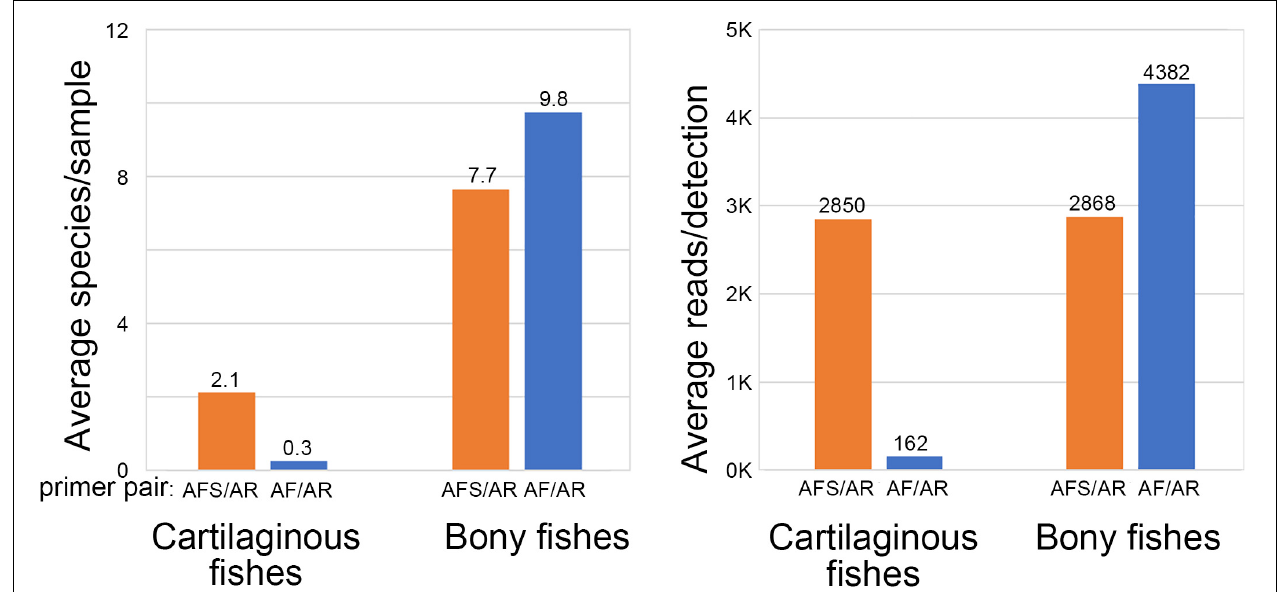
FIGURE 2 | Improved detection of cartilaginous fishes (sharks, rays, skates) with forward primer AFS.